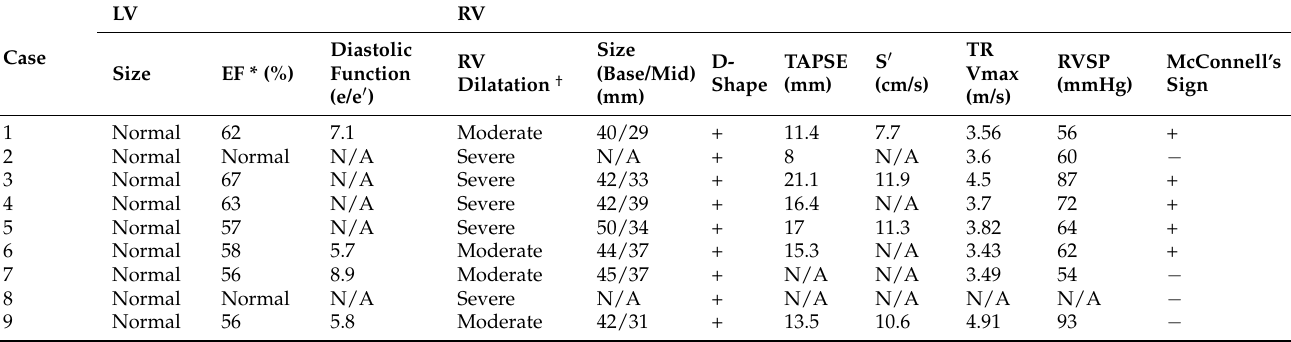
Table 3. Echocardiographic findings concerning patients with PTTM.